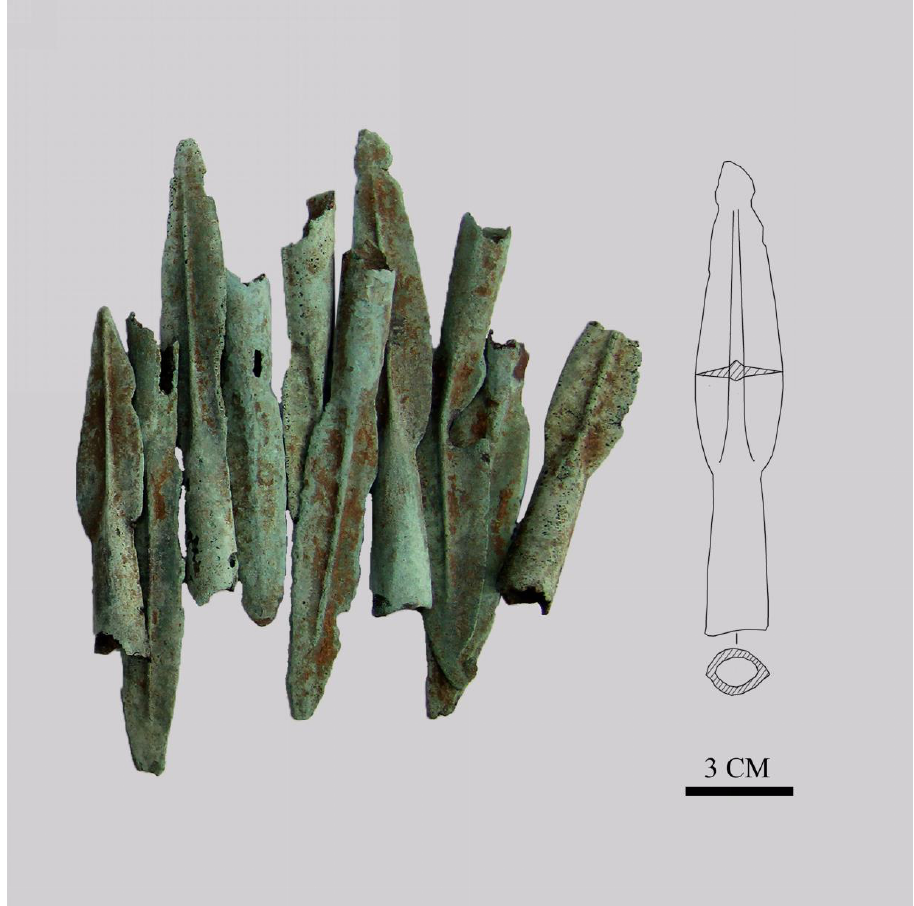
Figure 2. The spearheads analyzed in this study.